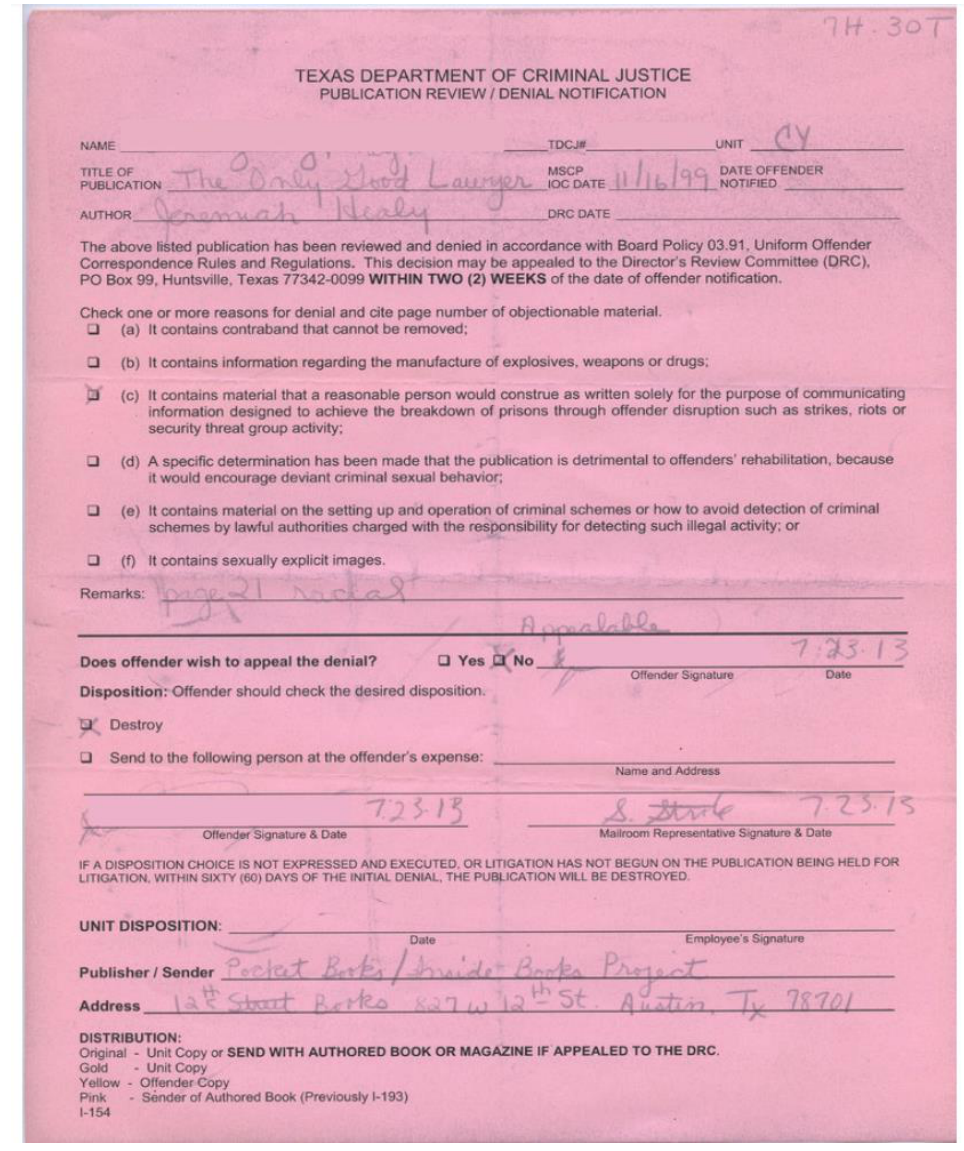
Figure 4. A Texas Department of Criminal Justice denial from for the book The Only Good Lawyer . The